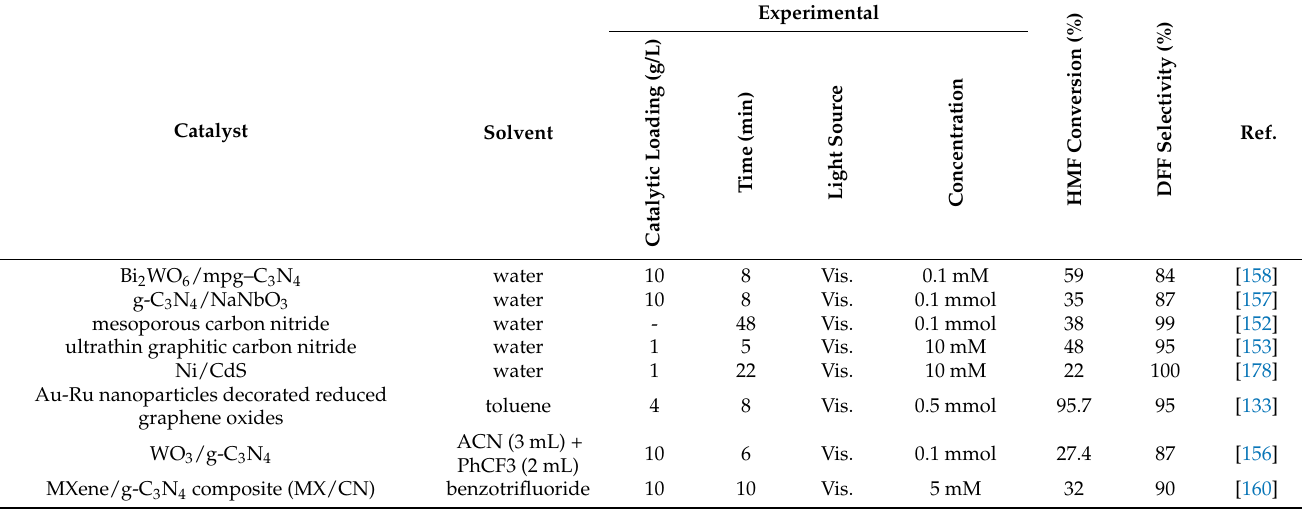
Table 2. Photocatalytic oxidation of HMF using novel